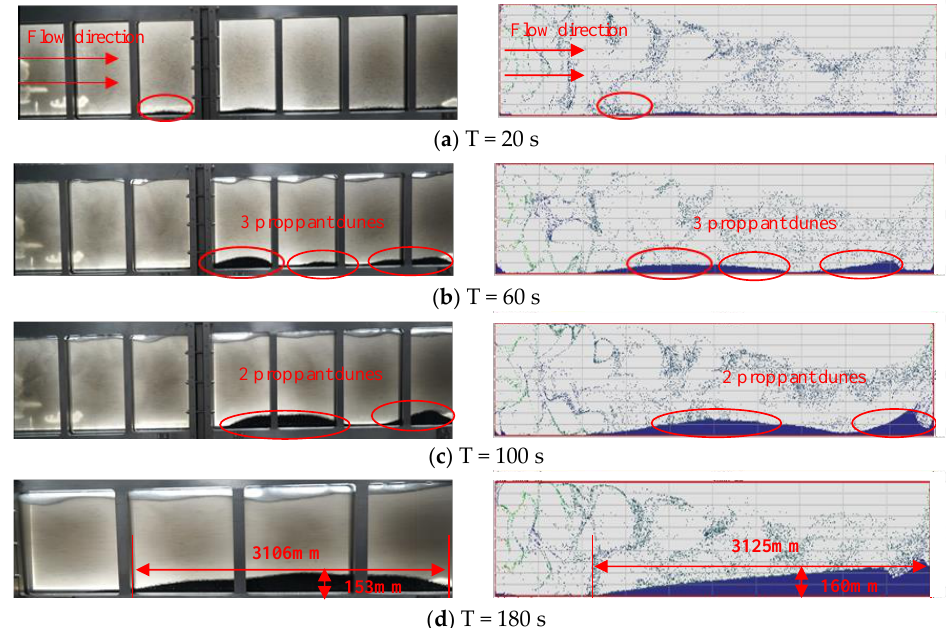
Figure 3. Experimental and numerical simulation results at different times: ( a ) T = 20 s; ( b ) T = 60 s; ( c ) T = 100 s; ( d ) T = 180 s.